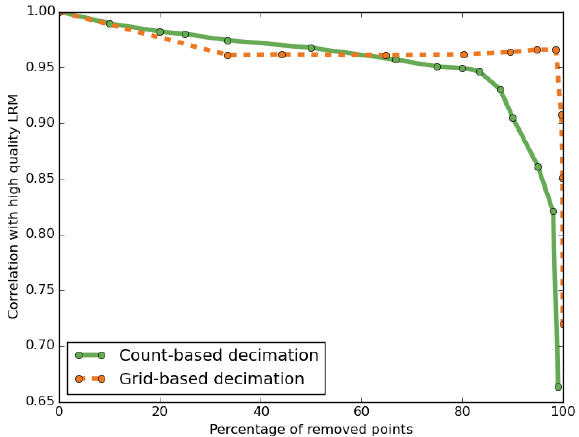
Figure 10: Comparison of the performance of count-based and grid-based decimation applied to a point cloud obtained using ground-based